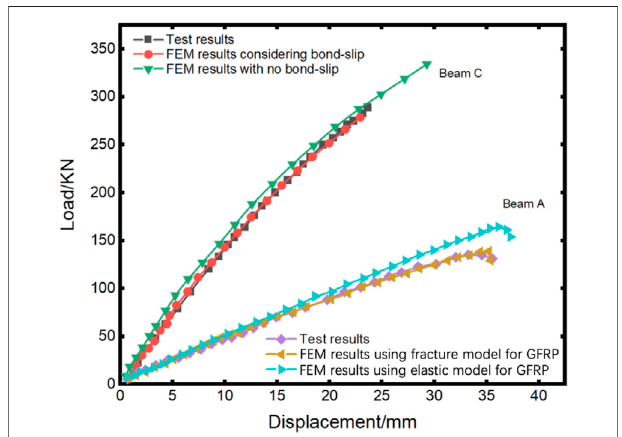
FIGURE 3 | Load – displacement curves of Beam A and Beam C.